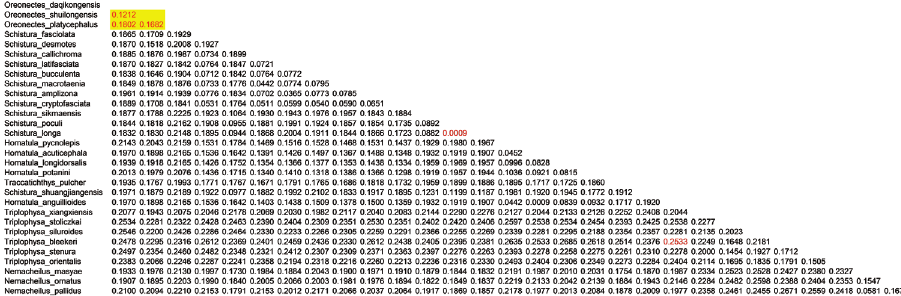
Figure 3. Genetic distance between O. daqikongensis sp. n. and species of